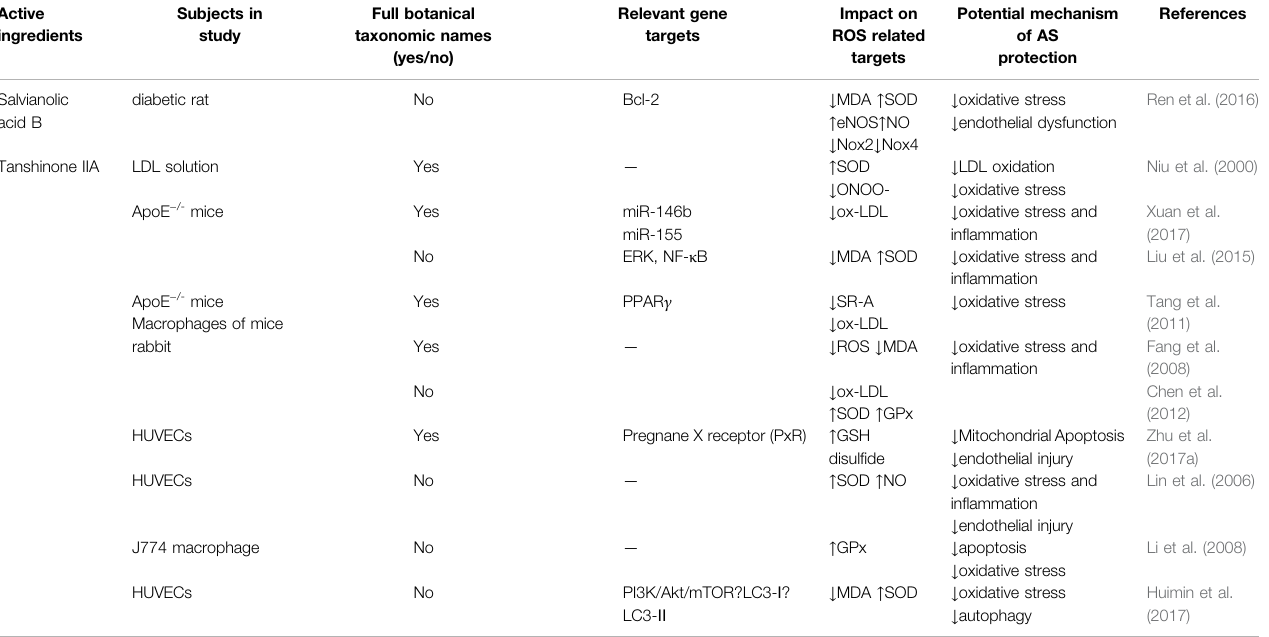
TABLE 4 | Active ingredients in Danshen for treatment of atherosclerosis by regulating oxidative stress. Active